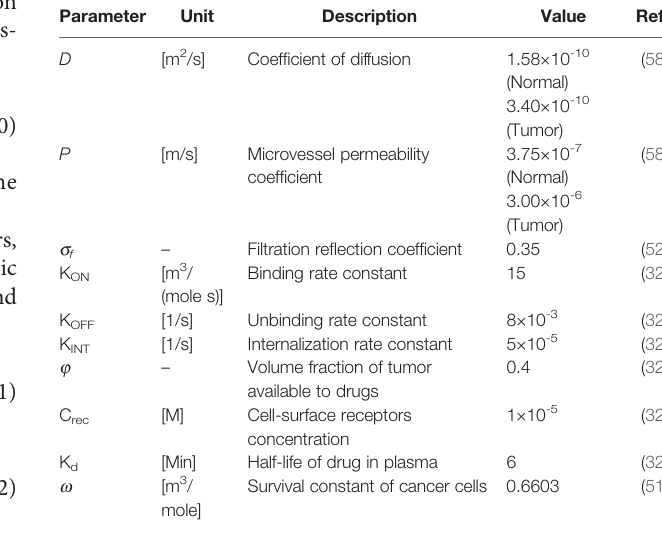
TABLE 3 | Parameters for chemotherapy drug (DOX) applied to computational